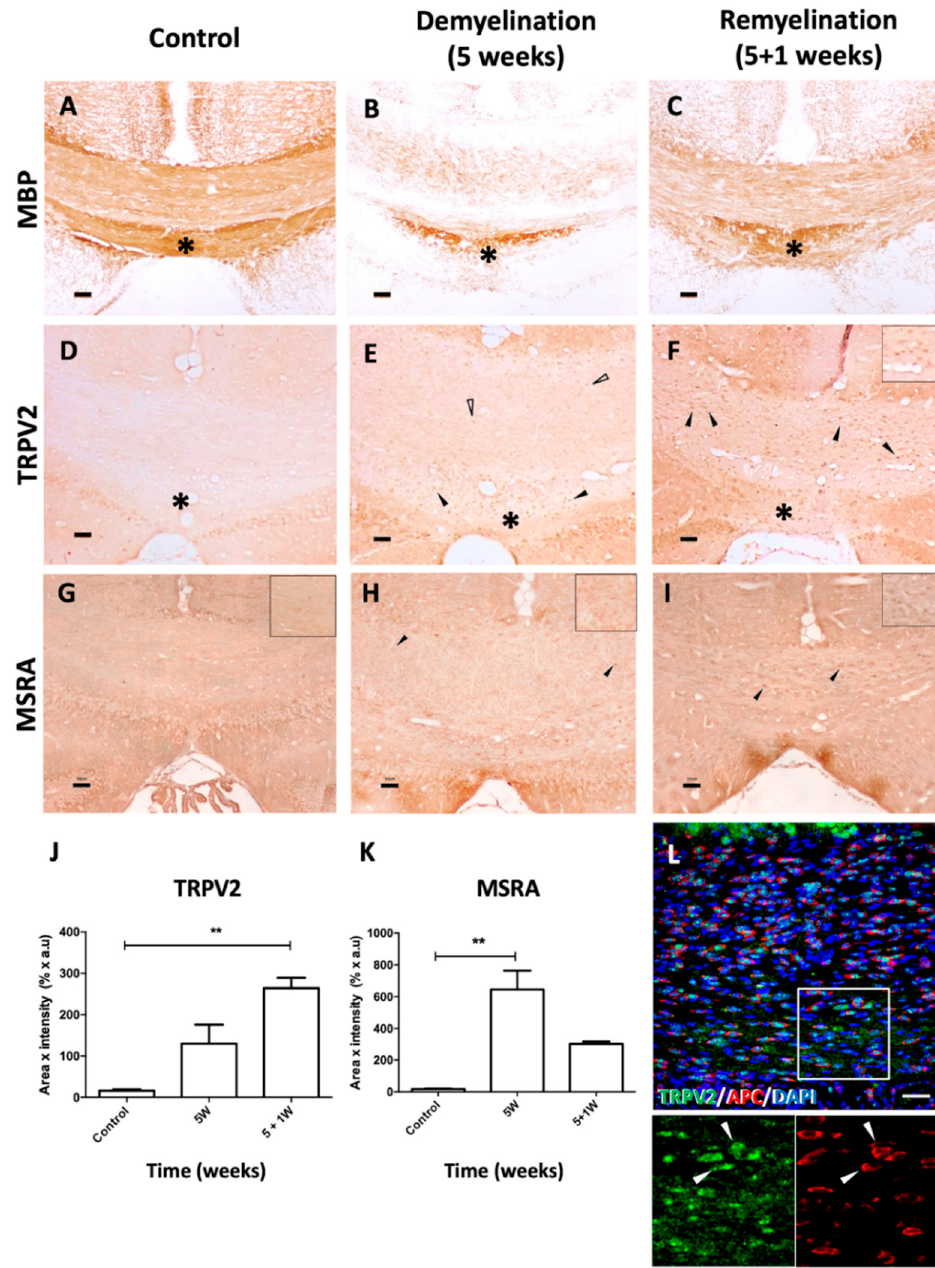
Figure 4. TRPV2 and MSRA expression in WM of cuprizone-induced demyelination and remyelination in mice. ( A – I ) Representative images of immunohistochemical staining directed against MBP, TRPV2 and MSRA in the CC of control mice ( A , D , G ) and cuprizone-intoxicated mice after demyelination ( B , E , H , 5 weeks of treatment) and during remyelination ( C , F , I , 5 weeks of treatment + 1 week of normal diet). ( A – C ) MBP immunostaining shows the myelinated CC of WT mice in basal conditions ( A ). At 5 weeks of cuprizone treatment, the CC is largely demyelinated ( B ) with a myelination-resistant area (*), and after one week of normal diet, the CC is mostly remyelinated ( C ). Control mice show undetectable levels of TRPV2 and MSRA in the CC ( D and G ). After demyelina- tion, variably low and high levels of TRPV2 were observed in cell bodies (empty arrowheads and arrowheads, respectively in E , F ). High levels of TRPV2 were clearly observed at remyelination (inset in F ). During remyelination, most TRPV2+ cells co-expressed APC (full arrowheads in L ), a marker for mature oligodendrocytes. In the CC area resistant to demyelination (* in E , F ), TRPV2+ cells showed high levels of expression in both conditions. An increase in MSRA levels of expression were also observed in cell bodies after demyelination and remyelination (arrowheads in H and I